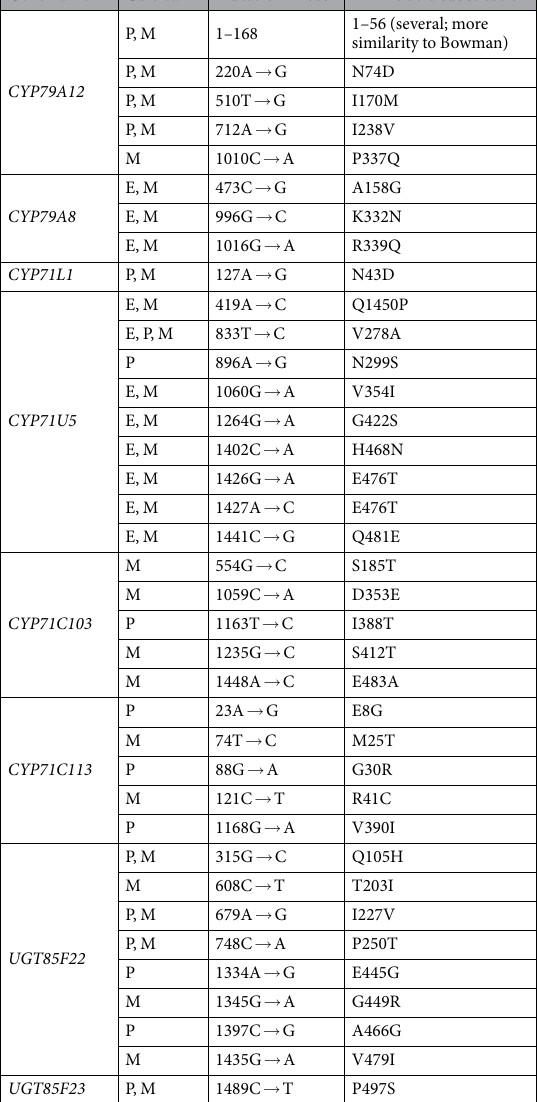
Table 1. Polymorphisms in the hydroxynitrile glucoside biosynthesis genes and resulting amino acid substitutions. Numbers indicate positions in the coding sequence and protein, and the mutations are in relation to the sequences in cv. Morex. Only mutations located within exons and causing an amino acid substitution in the mature proteins are shown. E, Emir; P, Pallas; M,